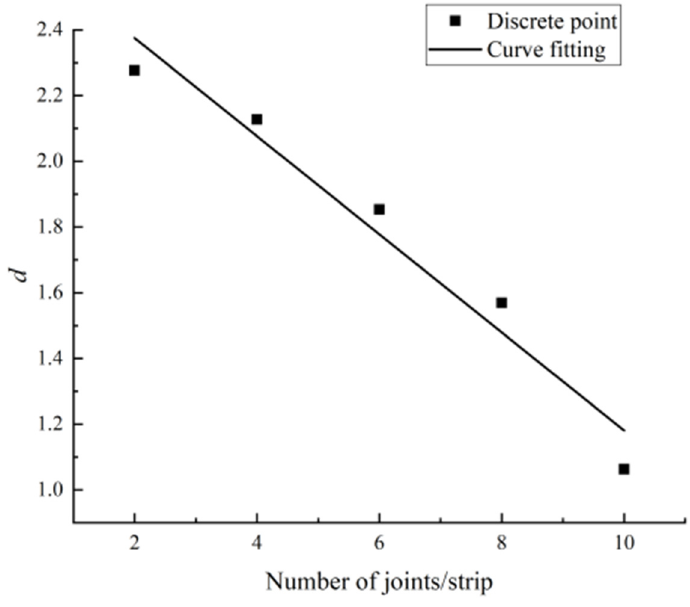
Figure 10. Fitting curve of parameter d .